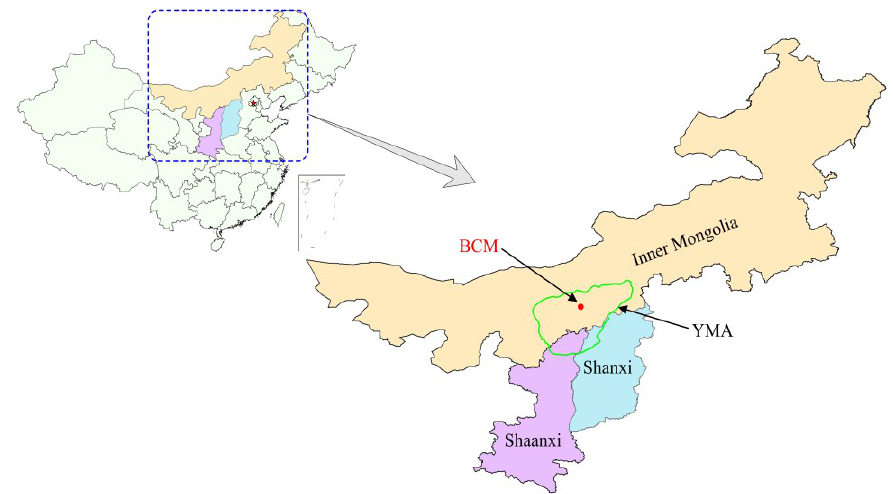
Figure 2. Location of the BCM in the YMA.